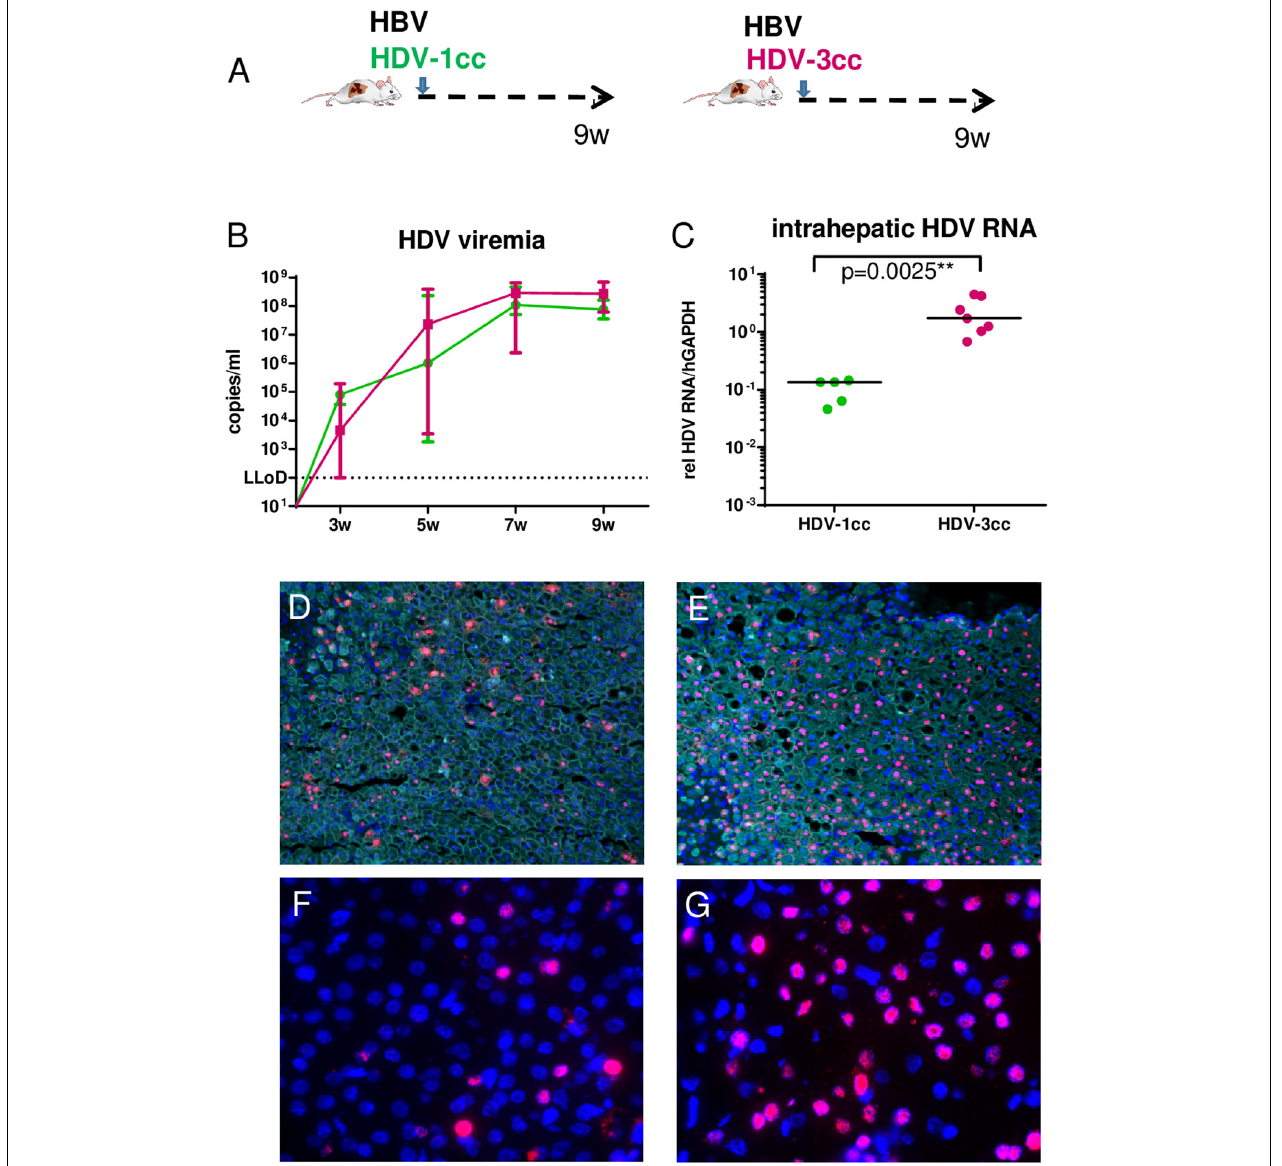
FIGURE 1 | HDV in mice co-infected with HBV and HDV-1cc or HDV-3cc. (A) Experimental setting. qRT-PCR measurements (HDV primers/probe recognize all genotypes) of serum HDV RNA (quantification with plasmid standard) (B) and liver HDV RNA (normalized to housekeeping gene hGAPDH) (C) in HBV/HDV-1cc (green) and HBV/HDV-3cc (red) co-infected mice 9 weeks post infection. Results are expressed as median ± range (B) , the bar shows median levels (C) . ** p < 0.01. Immunofluorescence staining of HDAg (red) and CK18 (detecting human hepatocytes, aqua) in HBV/HDV-1cc (D) and HBV/HDV-3cc (E) co-infected mice at the end of the experiment. Nuclei are stained with Hoechst 33258 (blue). RNA in situ hybridization staining of AG HDV RNA (red) in HBV/HDV-1cc (F) and HBV/HDV-3cc (G) co-infected mice at the end of the experiment. Nuclei are stained with dapi